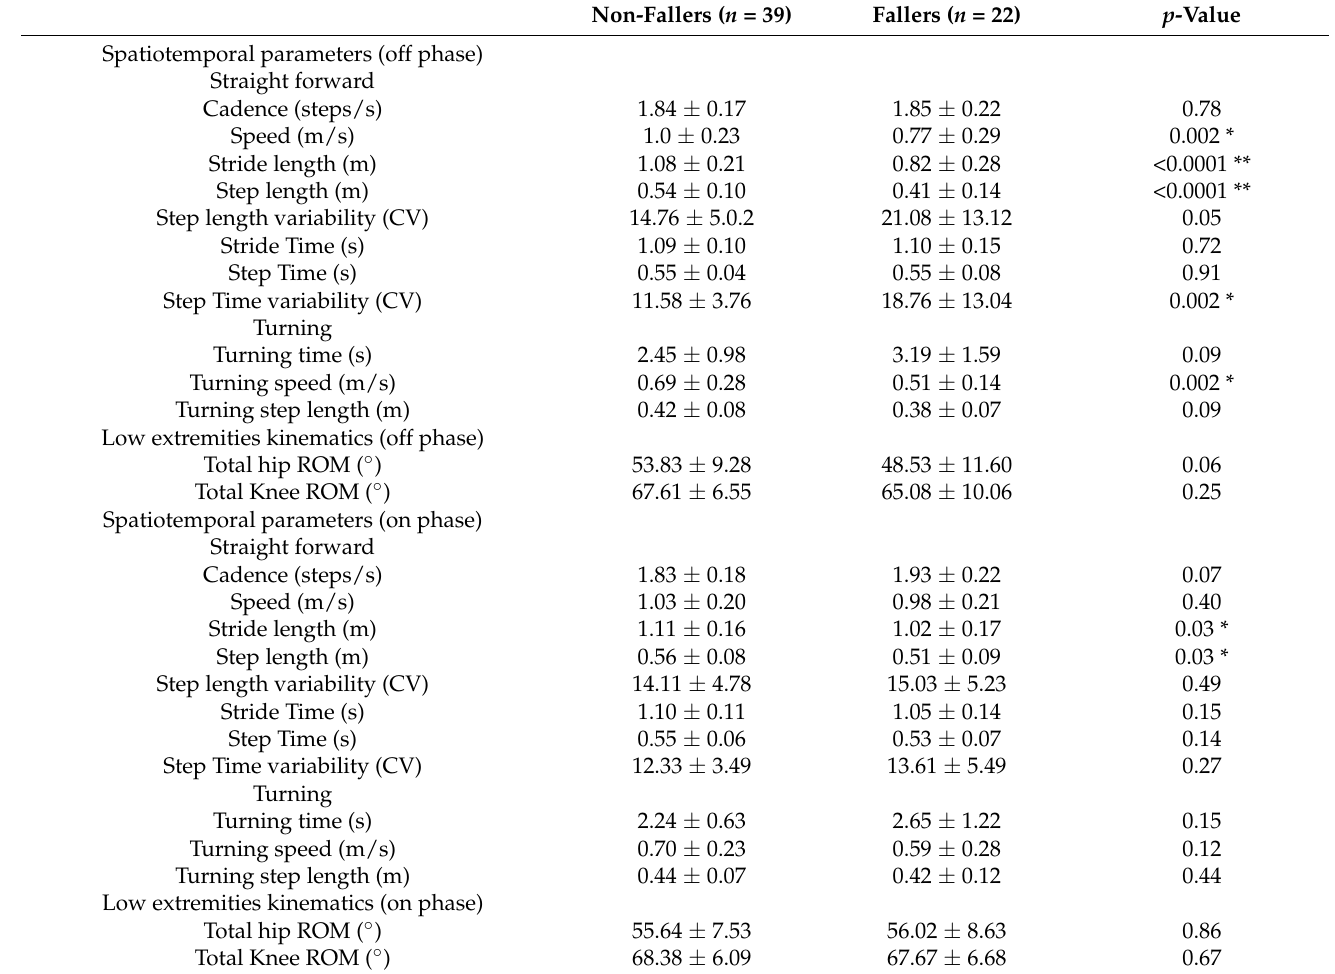
Table 2. Baseline spatiotemporal and kinematic variables during the walking gait cycle. Non-Fallers ( n = 39) Fallers ( n = 22) p